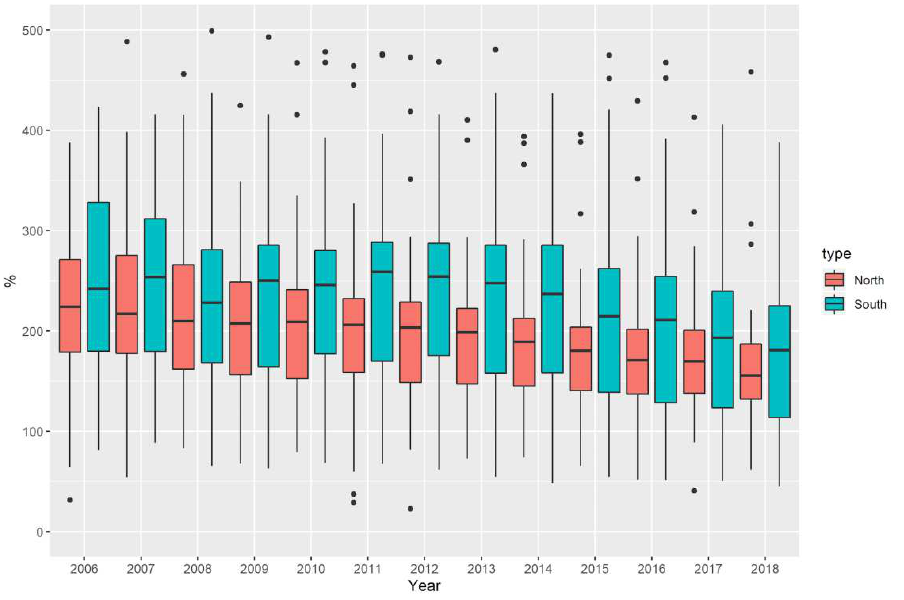
Figure 4. Liabilities-to-equity ratio (2006–2018)